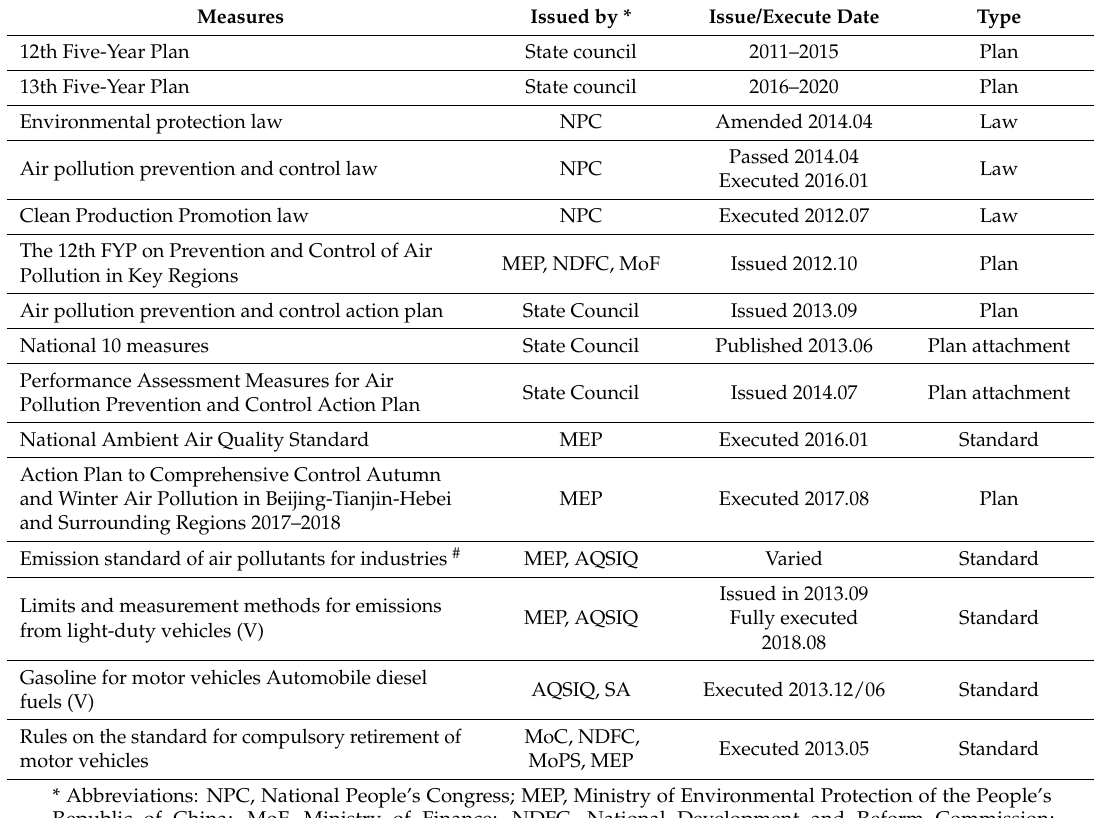
Table A2. Major air quality control strategies since